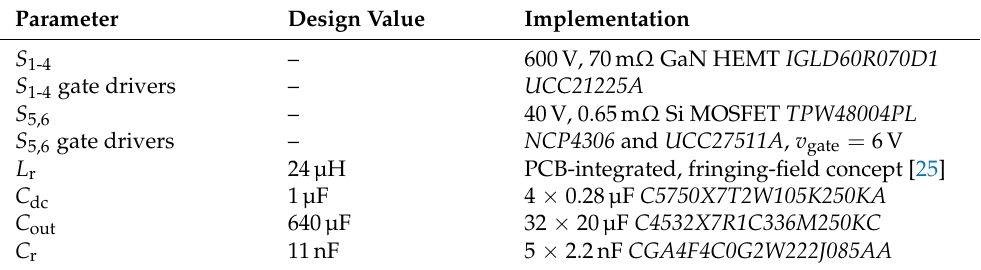
Figure 11. The 1.5kW hardware demonstrator of the DC/DC resonant converter, measuring 96mm 66mm 11.5mm. Key components and measurement devices are highlighted, with key values × × and implementations given in Table 6. Table 6. Key design values and implementation for components in the 1.5kW hardware demonstrator of Figure